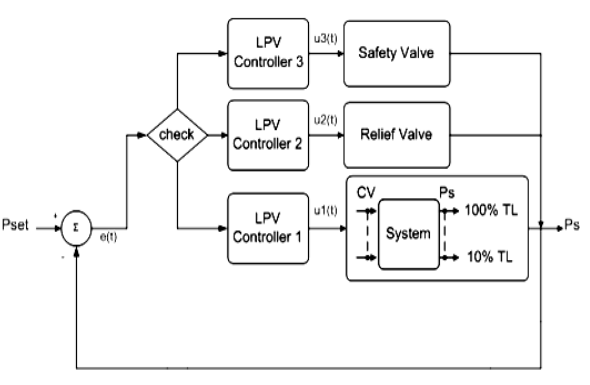
Fig. 5. Closed loop dump valves oriented steam dump control system